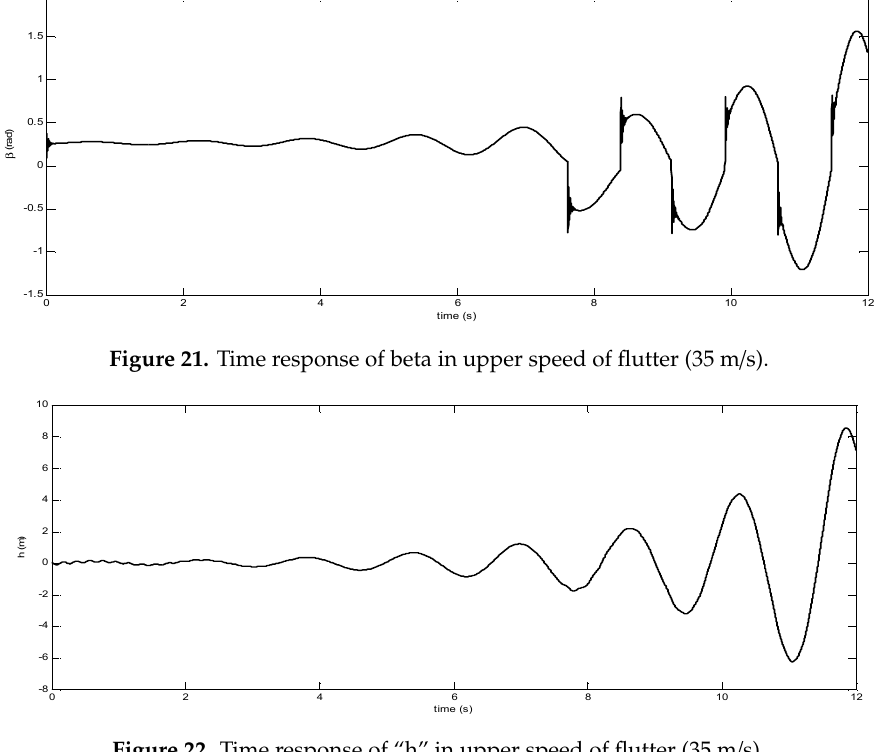
Figure 22. Time response of “h” in upper speed of flutter (35 m / s).